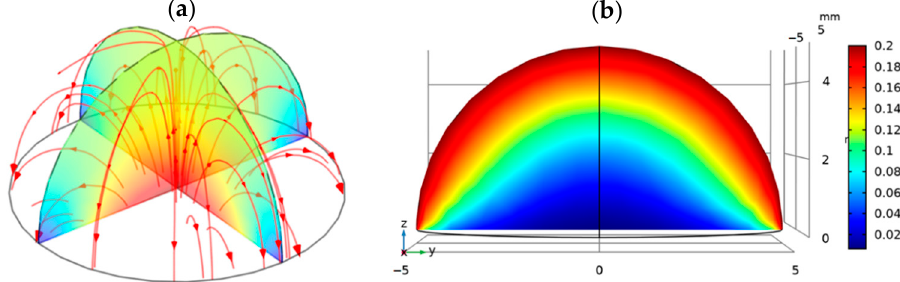
Figure 5. ( a ) Graphic representation of the secondary current and potential distribution inside the drop; ( b ) dissolved oxygen concentration diffusion profile through the drop mol m − 3 .